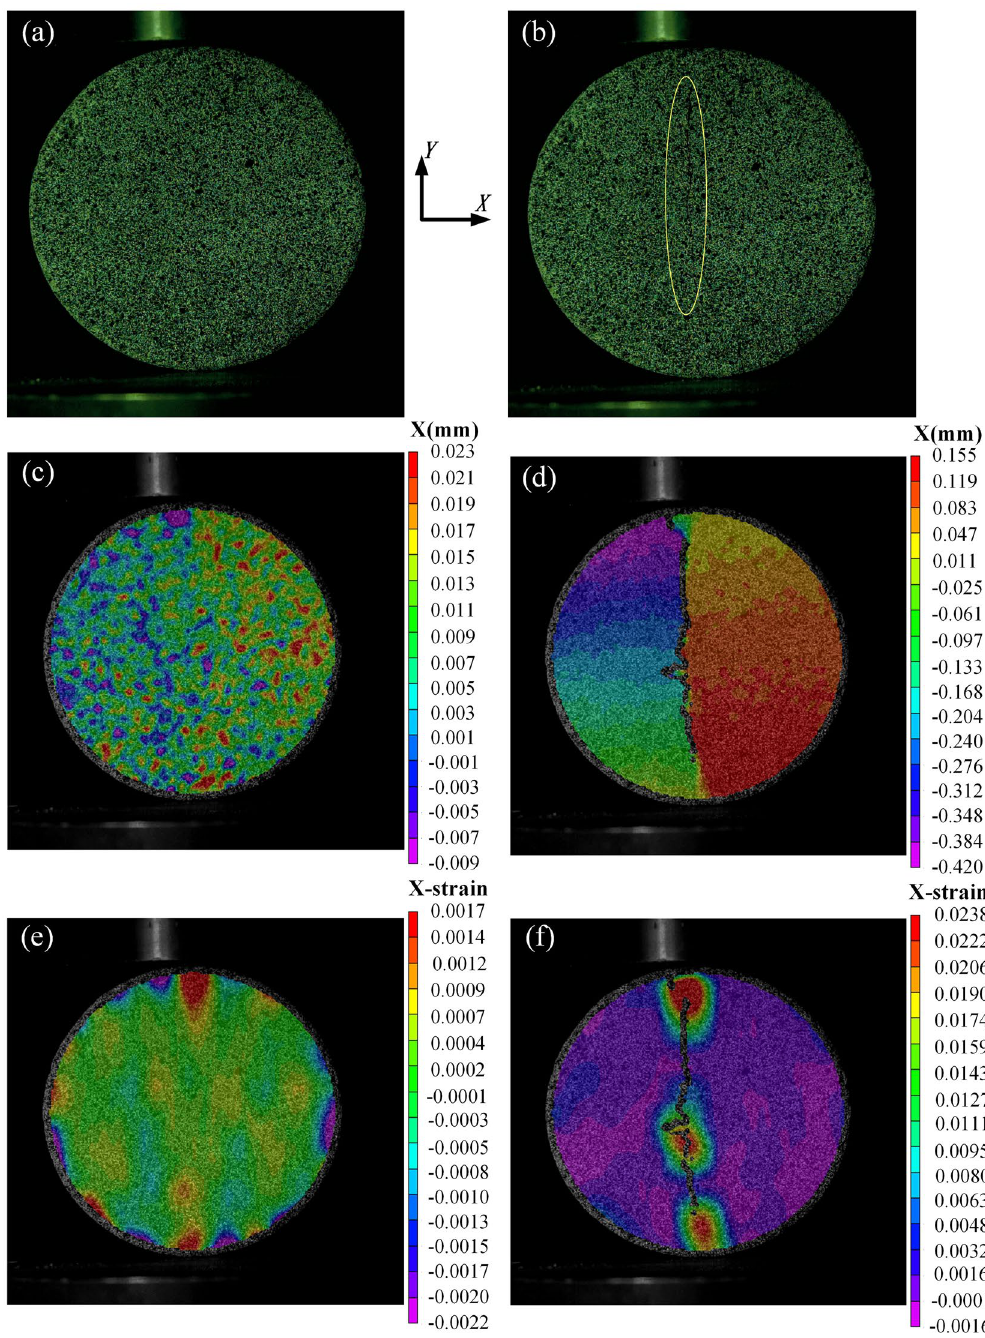
Figure 9. Failure modes of specimen M-L-4: ( a , c , e ) are morphology, displacement and strain maps perpendicular to the loading direction before failure ( t = 279.60 s); ( b , d , f ) are their corresponding maps after failure ( t = 279.65